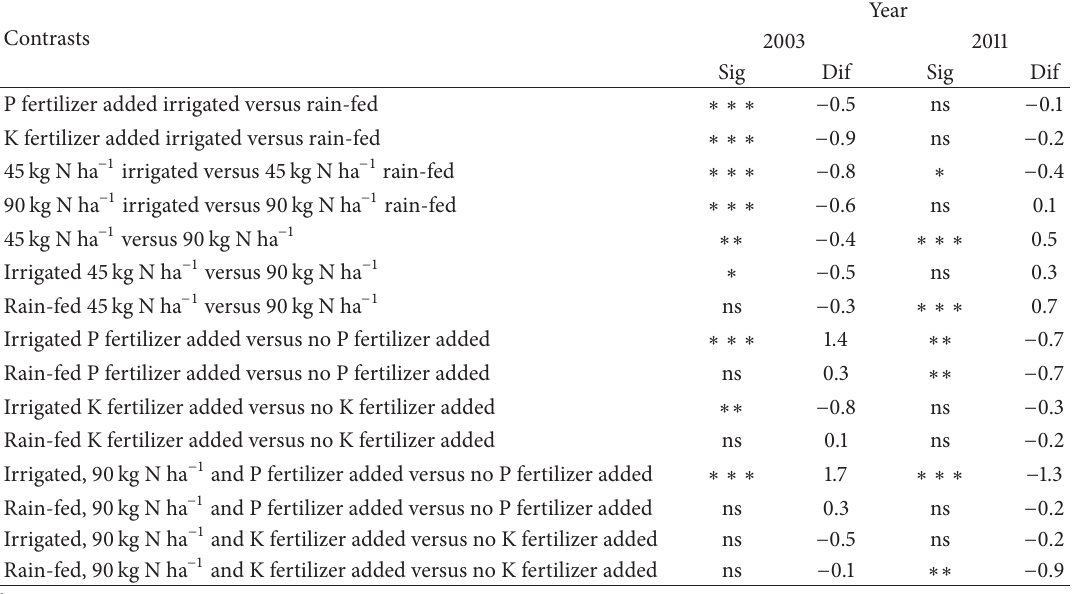
a Standard error of the difference for the interaction of fertilizer treatment and water treatment. ∗ , ∗∗ , and ∗ ∗ ∗ are significant at the 0.1, 0.01, and 0.001 level, respectively. ns: not significant at the 0.1